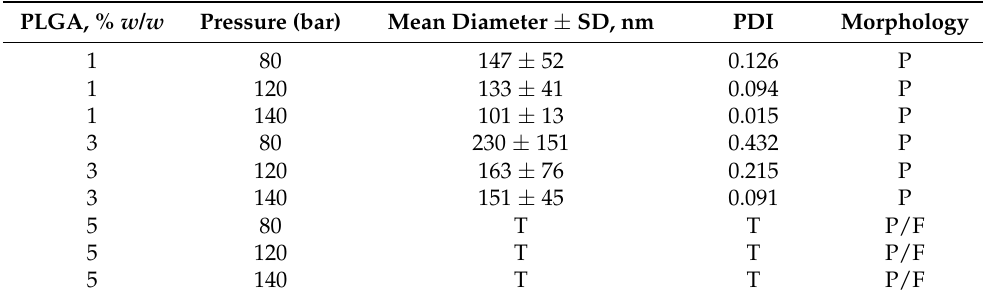
Table 1. Particles mean diameter, SD and PDI obtained at different PLGA concentrations and pressures; applied voltage 30 kV.